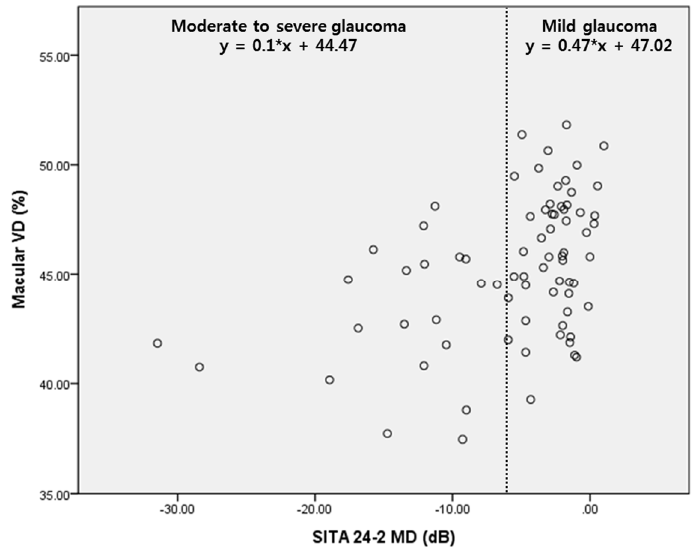
Figure 3. Scatter plot showing the relationship between MD of SITA 24-2 and macular vessel density (VD). There was more delicate change of macular VD according to MD in mild glaucoma. Table 3. Factors associated with the average macular VD in total subjects.